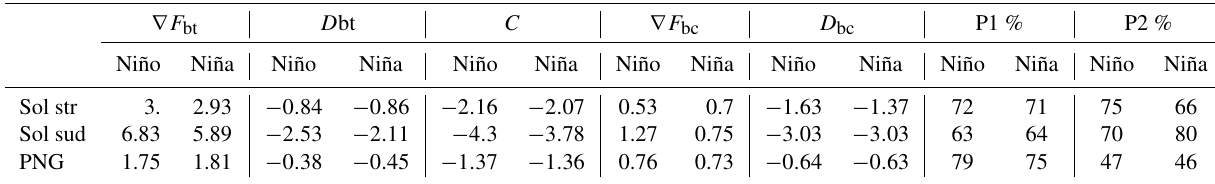
Table 1. ∇ F bt ( ∇ F bc ) is the divergence of the barotropic (baroclinic) flux, D bt ( D bc ) is the dissipation of the barotropic (baroclinic) flux, and C is the conversion rate from barotropic to baroclinic energy. Units are in gigawatts. P1 is the percentage of the barotropic energy converted into baroclinic energy, and P2 is the percentage of the baroclinic energy dissipated within the box. ∇ F bt D